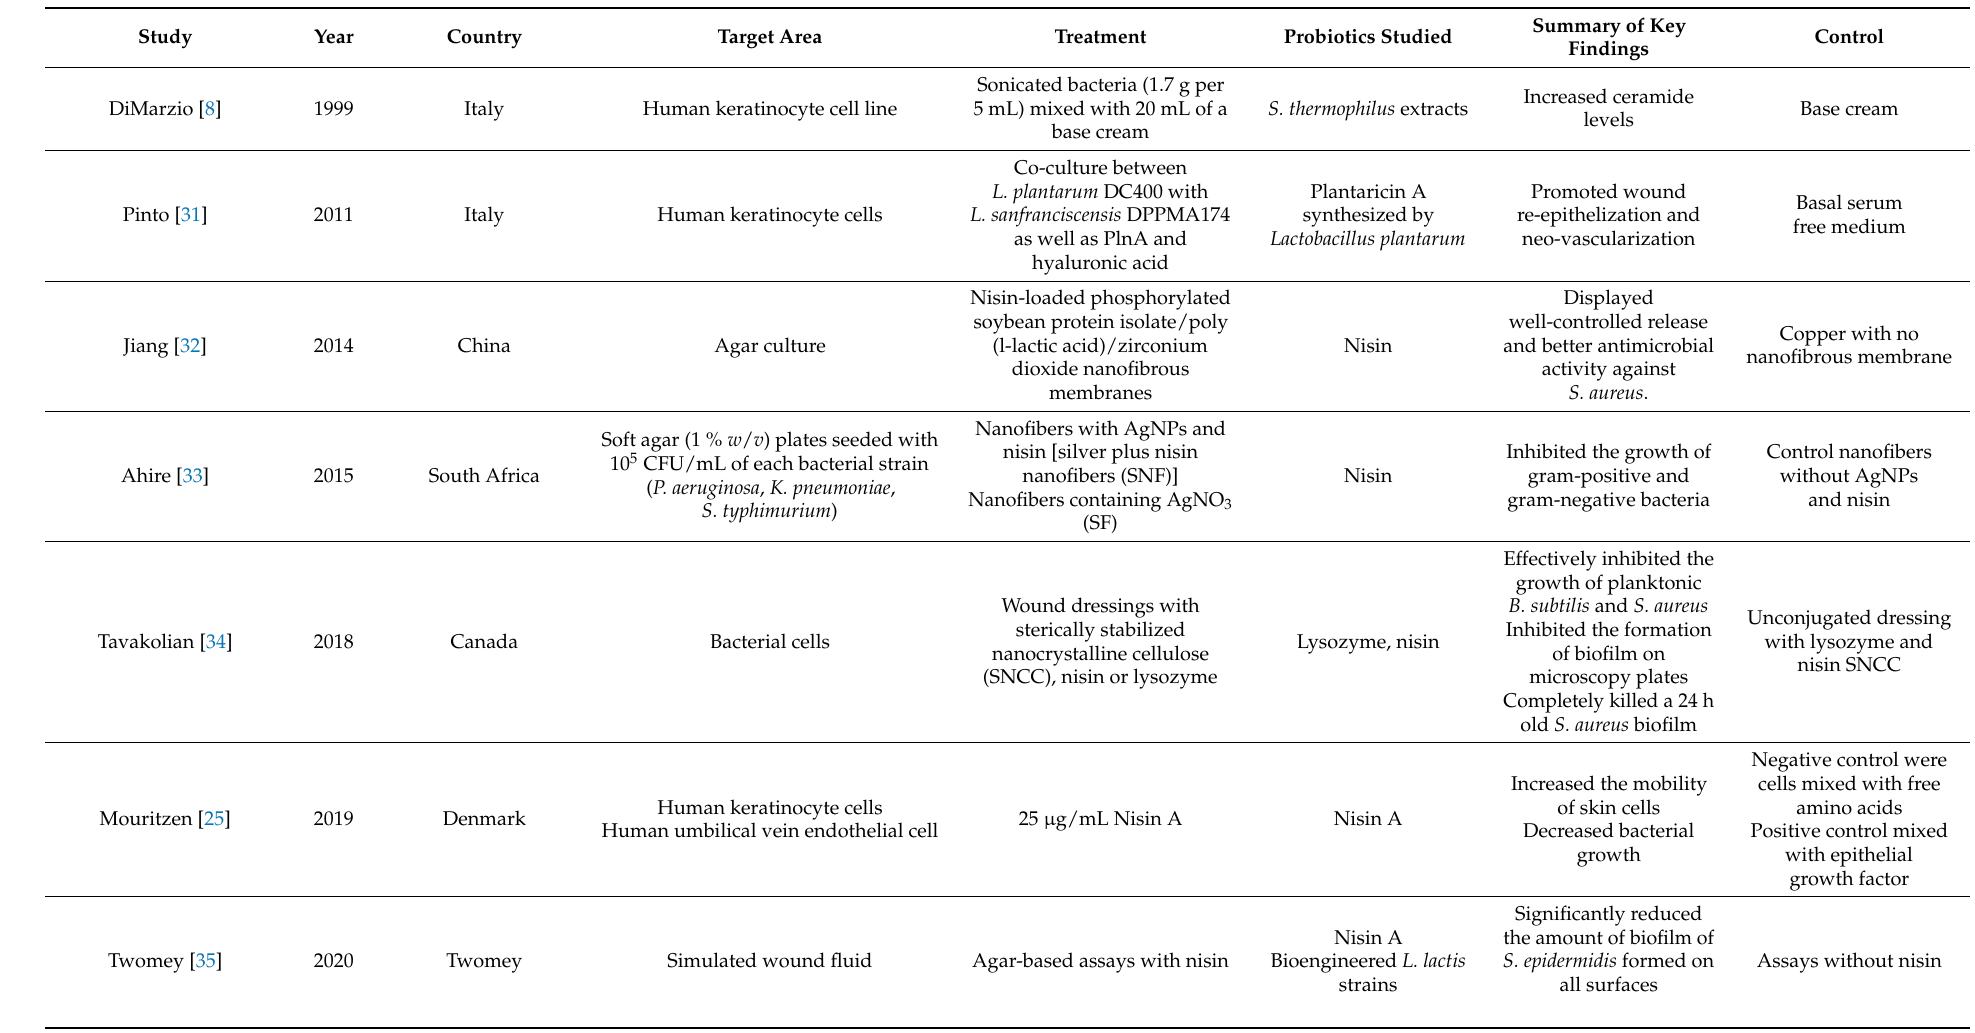
Table 2. Detailed summary of in vitro studies included. All the outcomes noted are significantly different from the control groups applied in every study.